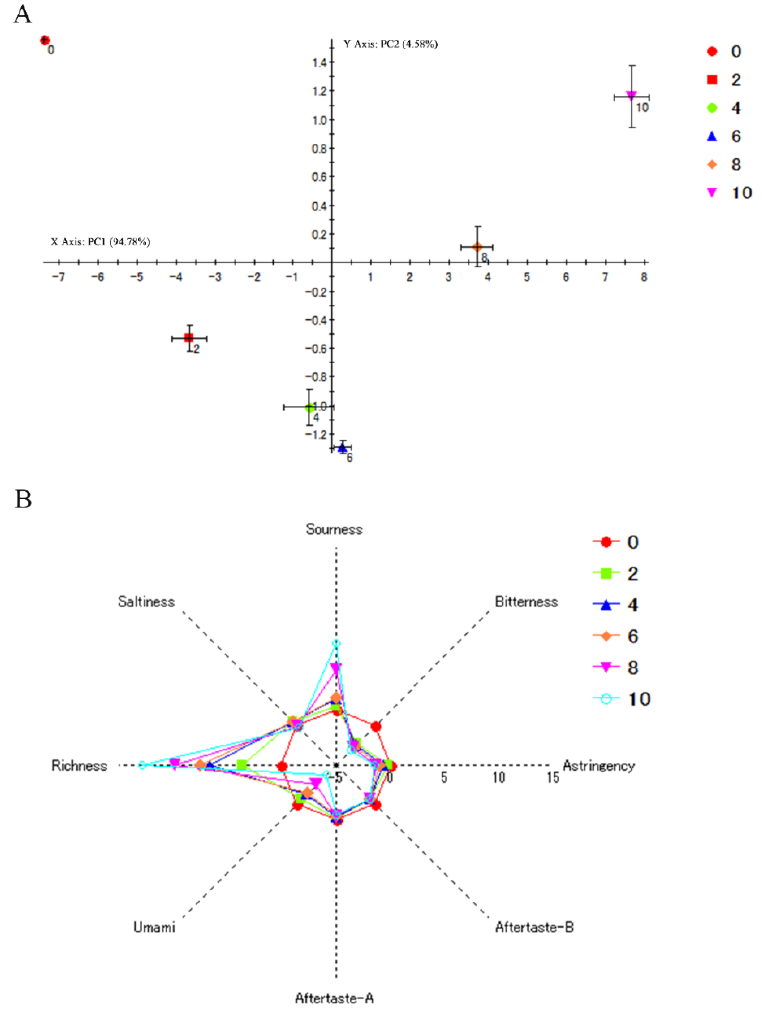
Figure 3. The analysis of shrimp head by E-tongue. ( A ) The principal component analysis of E-tongue; ( B ) The Radar chart analysis of E-tongue.